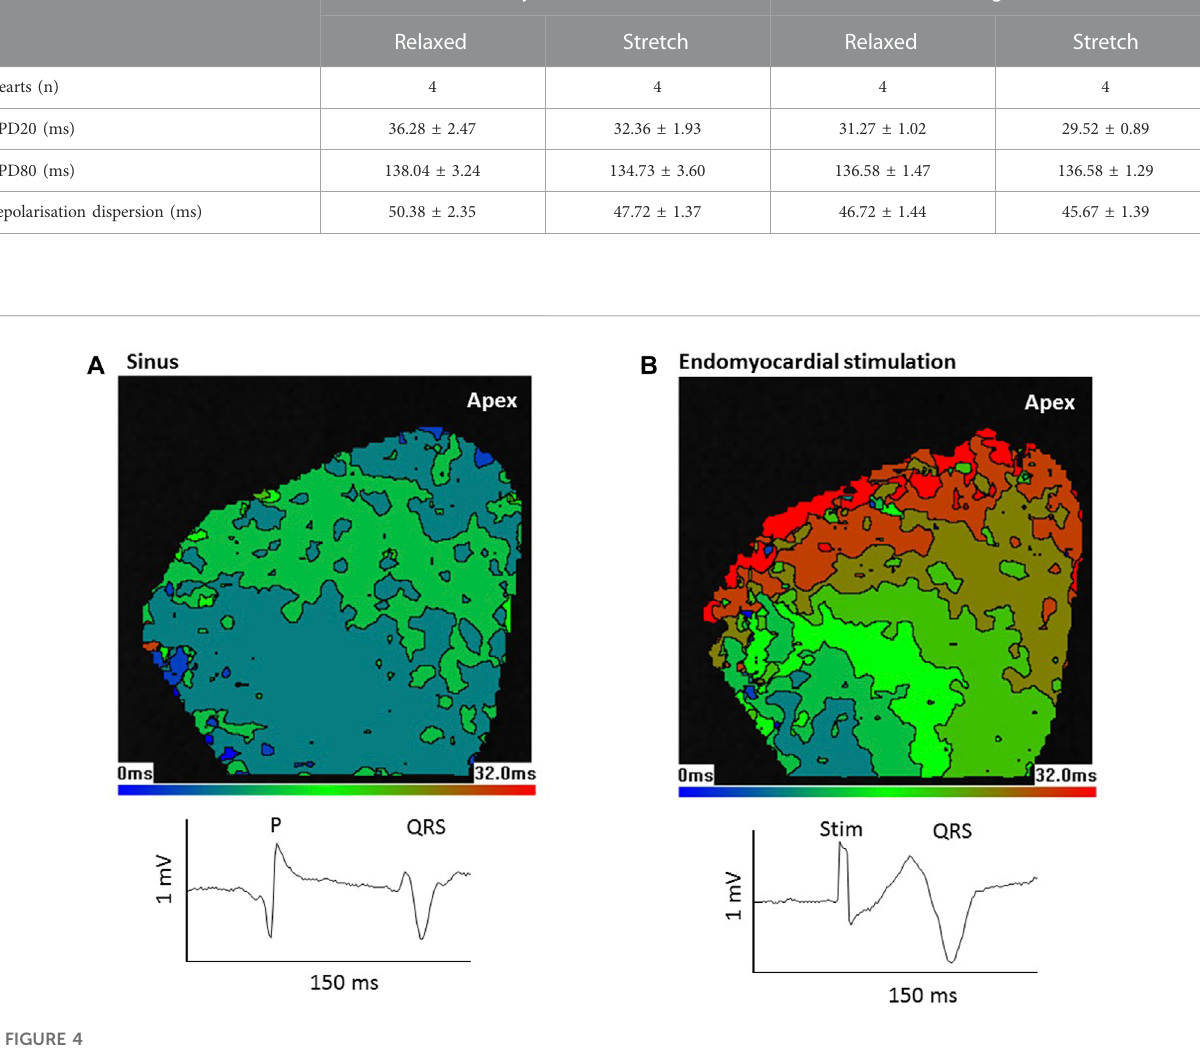
FIGURE 4 Epicardial activation from sinus stimulation spreads faster than from endomyocardial stimulation. Optical mapping of left ventricular (LV) epicardial activation in response to (A) sinus stimulation or (B) focal endomyocardial stimulation near the LV base. Images show colour coded 4 ms contours. Images are 80 × 80 pixels in 26 mm squares. In response to sinus stimulation, which involves conduction through the Purkinje network, early activation occursatthebaseandapexandthereisarapidspreadofactivation.Incontrastfocalendomyocardialstimulationresultsinasmallbasalareaofinitial activation that spreads slowly to the apex. Thus, the activation pattern gives information about the stimulation source. Lower traces show sections from the pseudo-ECG; P wave and QRS in sinus and stimulus artefact (Stim) and QRS in endomyocardial stimulation. Consistent with the slower epicardial activation, QRS is longer following endomyocardial